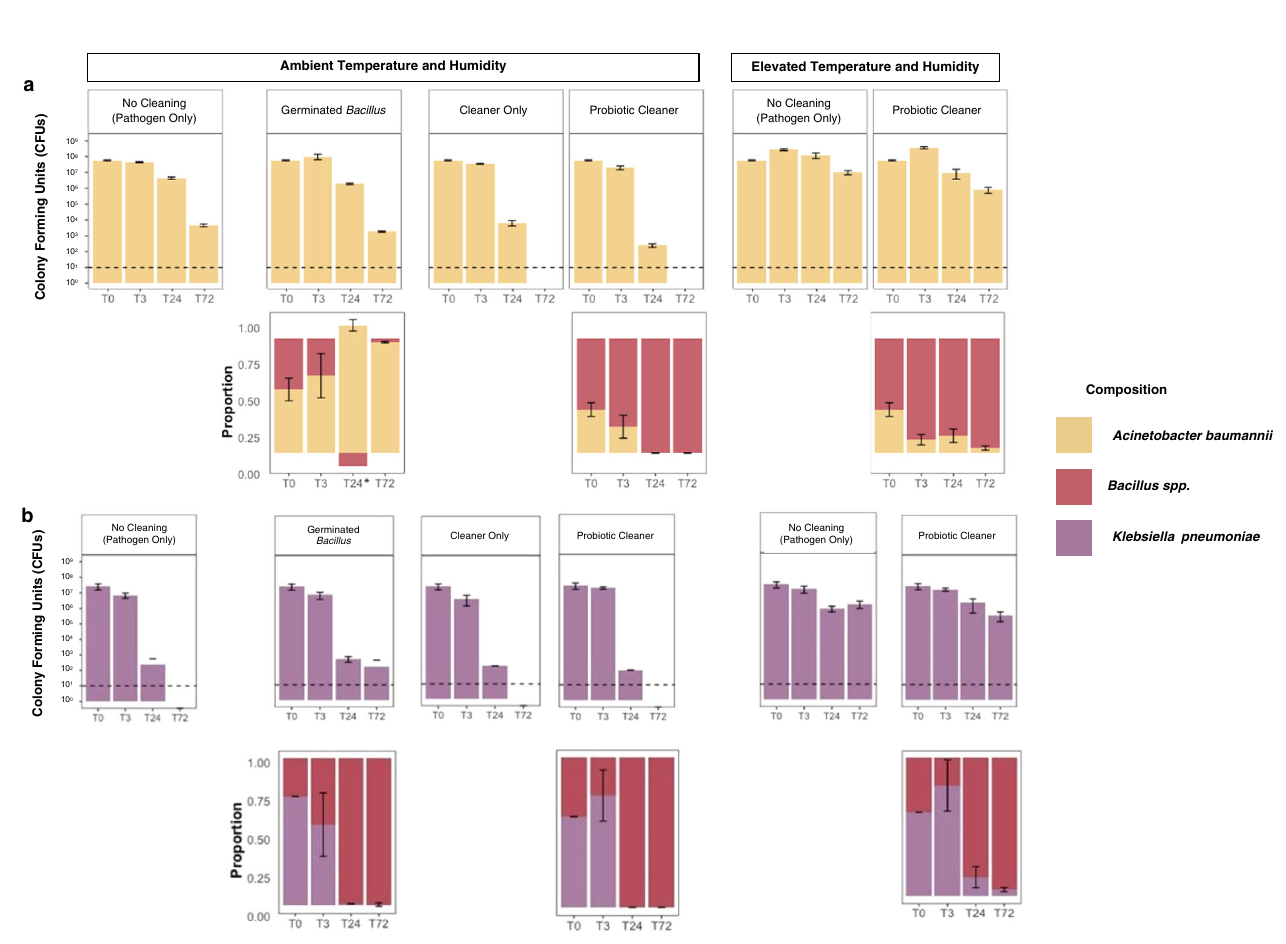
Fig. 2 Culture-based survival of pathogens. Colony forming units (CFU) of pathogens A. baumannii ( a ) and K. pneumoniae ( b ) and composition of surface microbial community under four cleaning scenarios and two temperature and humidity conditions. CFUs of pathogens were counted on day 3 of incubation (37 o C) on their selective media while total CFUs (pathogen and Bacillus spp.) were obtained from TSA. The proportions of A. baumannii and K. pneumoniae were calculated as the ratio between CFU from their selective media and CFU . Dashed lines represent a limit of detection (LOD) of 10 from TSA. The proportion of Bacillus spp. was calculated as 1 (cid:1) CFU ð CHROM or M acConkey Þ CFU ð TSA Þ CFU. Error bars represent standard deviations. * Due to possible technical variation, the proportion of A. baumannii exceeded 1 at T24 for A. baumannii Germinated Bacillus